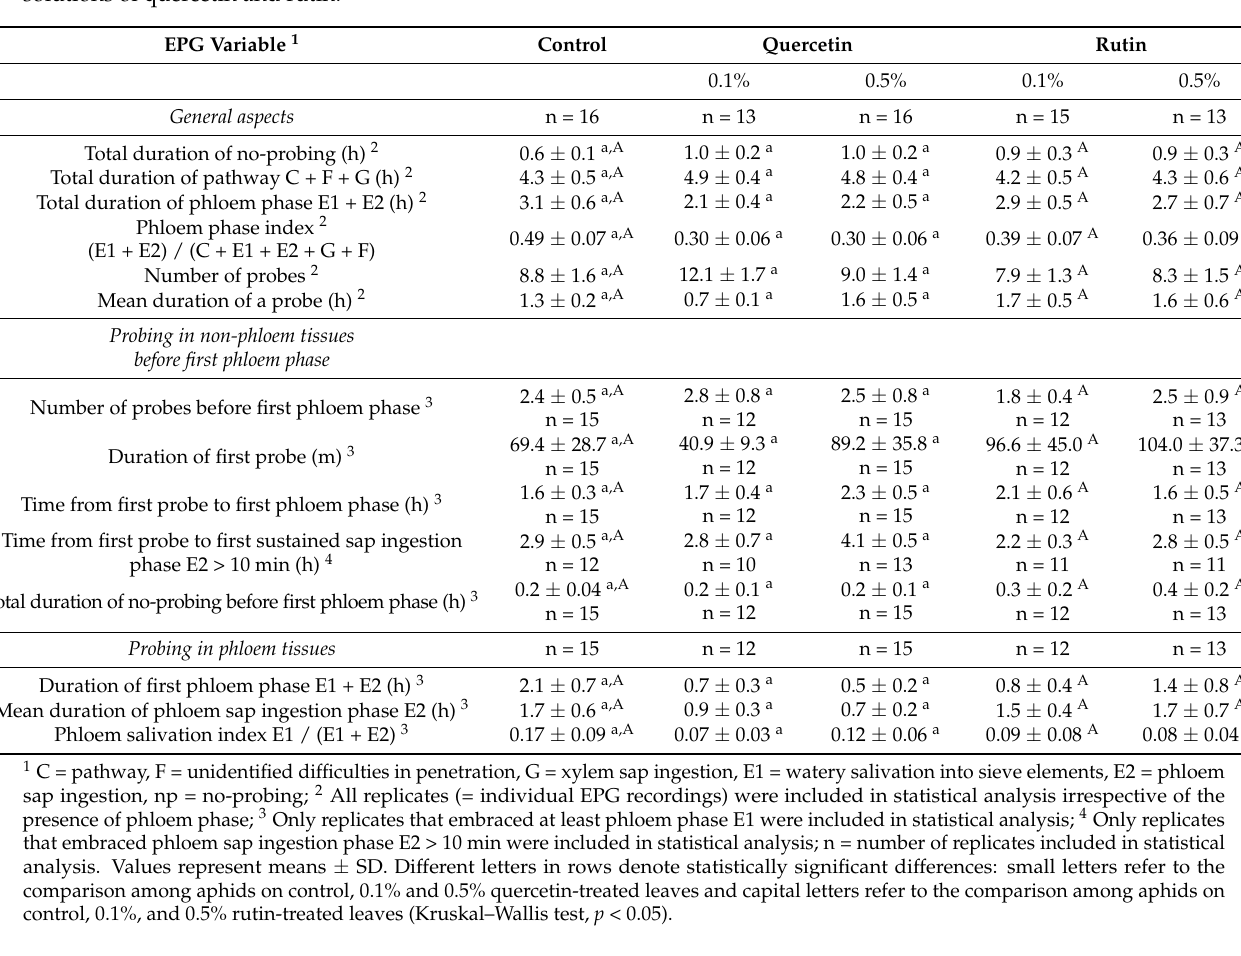
Table 3. EPG-recorded stylet penetration activities of Rhopalosiphum padi on Avena sativa treated with 0.1% and 0.5% ethanolic solutions of quercetin and rutin.